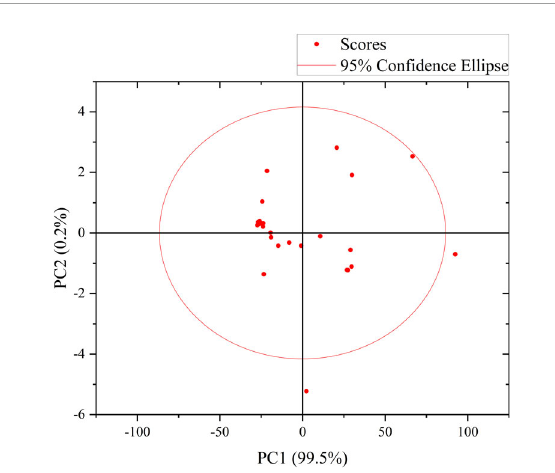
FIGURE7 Score diagram of KPCA of thiram enhanced by Au-NPs solution.